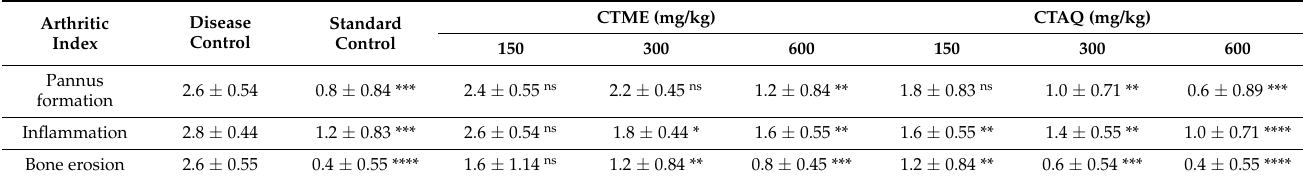
Table 3. Effect of C. tuberculata extracts on the arthritic